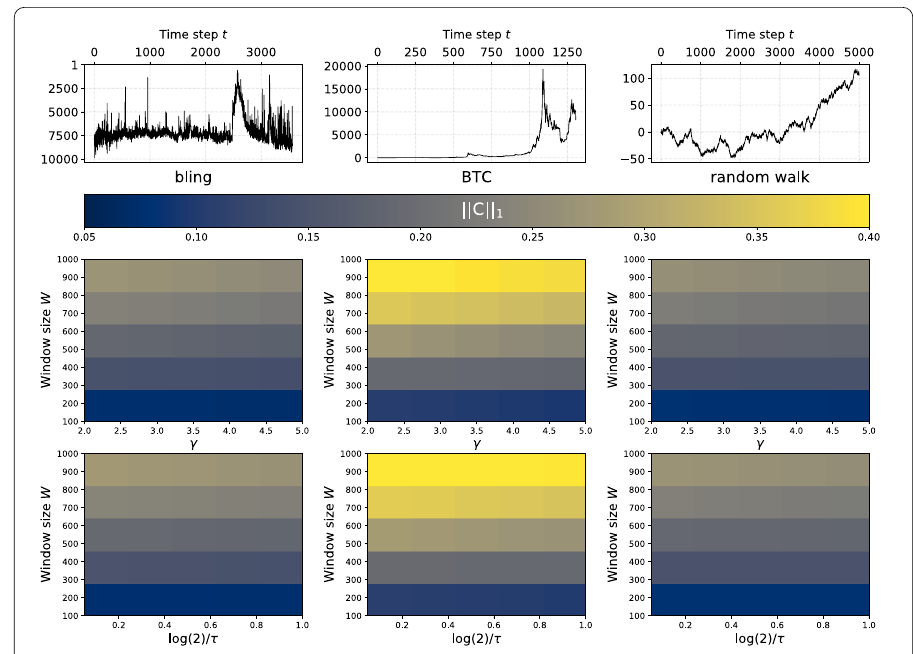
Figure 6 Parameters Sweep. The shock indicator function is relatively insensitive to functional forms K ( · ) and values of the kernel’s parameter vector θ so long as the kernel functions are qualitatively similar (e.g., for cusp-like dynamics—as considered in this figure and in Eq. (10)— K ( C ) displaying increasing rates of increase followed by decreasing rates of decrease). Here we have computed the shock indicator function C K ( S ) ( τ | θ ) (Eq. (12)) for three different time series: two sociotechnical and one null example. From left to right, the top row of figures displays the rank usage time series of the word “bling” on Twitter, the price of the cryptocurrency Bitcoin, and a simple Gaussian random walk. Below each time series we display parameter sweeps over combinations of ( θ , W max ) for two kernel functions: one kernel given by the function of Eq. (10) and another of the identical form but constructed by setting K ( S ) ( τ | W , θ ) to the function given in Eq. (1). The (cid:11) 1 norms of the shock indicator function are nearly invariant across the values of the parameters θ for which we evaluated the kernels. However, the shock indicator function does display dependence on the maximum window size W max , with large W max associated with larger (cid:11) 1 norm. This is because a larger window size allows the DST to detect shock-like behavior over longer periods of